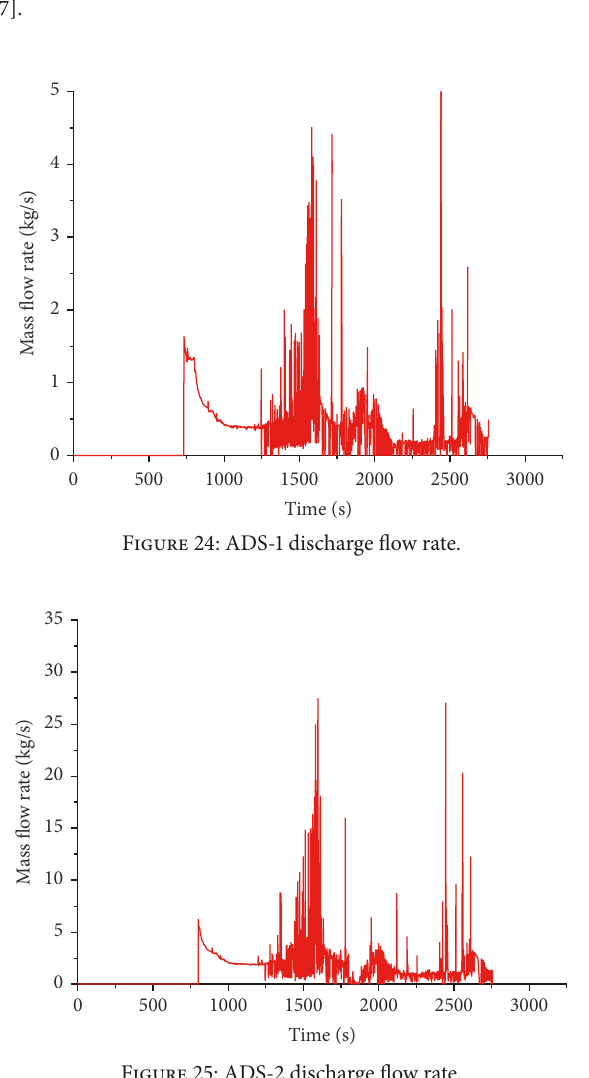
Figure 25: ADS-2 discharge flow rate.